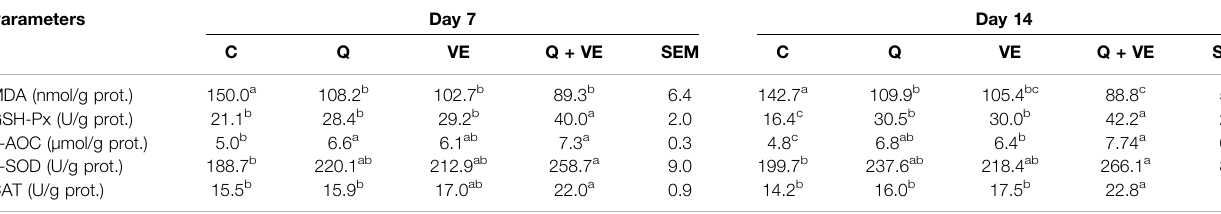
TABLE 4 | Effects of dietary Q, VE, and Q + VE on egg yolk antioxidant status. Parameters